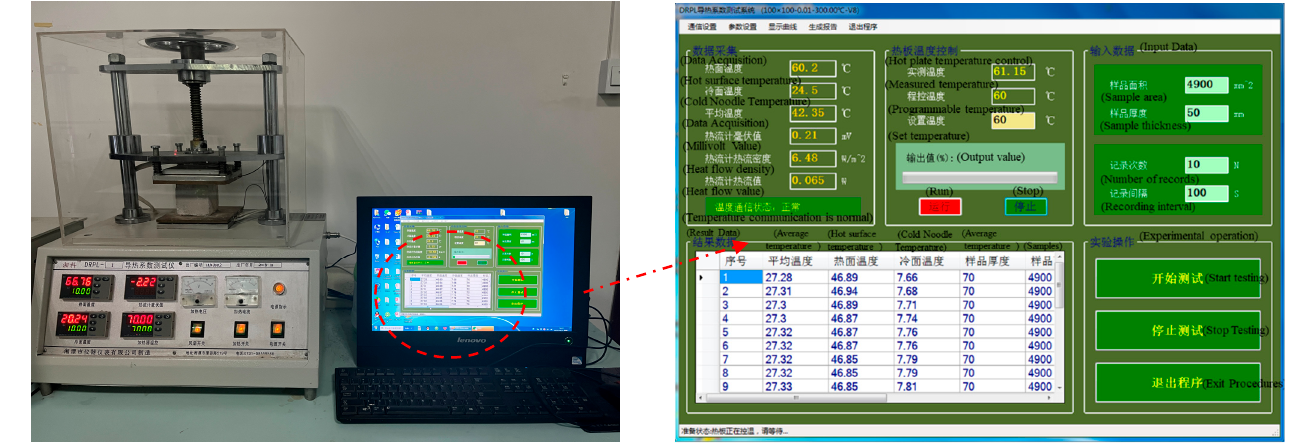
Figure 3. DRPL-I Thermal Conductivity Tester.